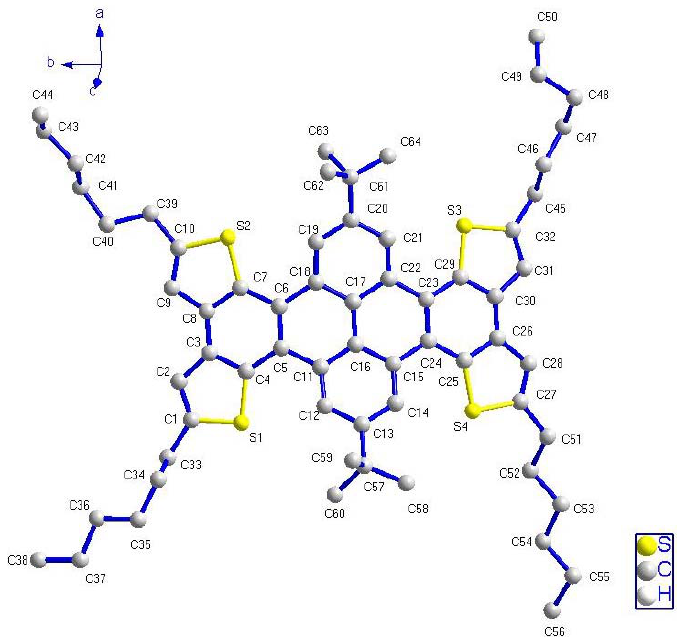
Figure 5. View of THTP-C showing the atomic numbering. Hydrogen atoms have been omitted for